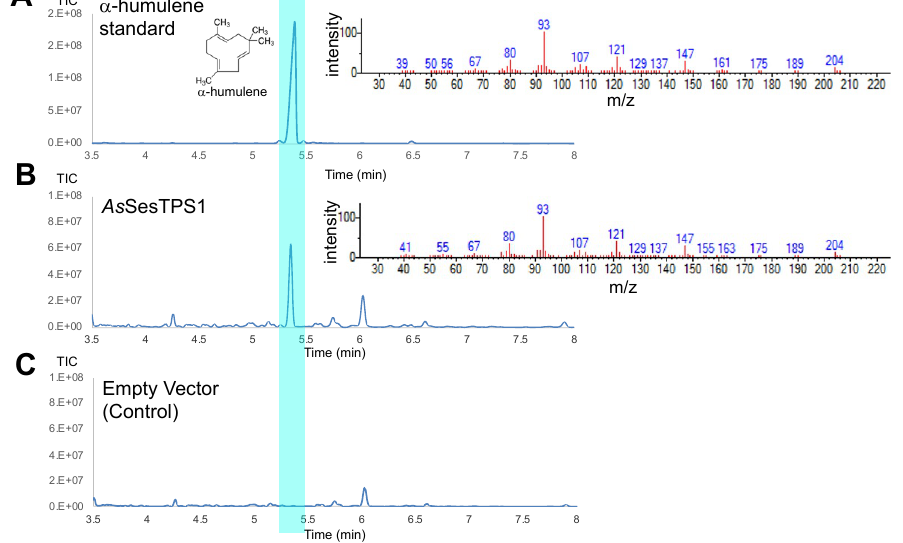
Figure 4. Total ion chromatograms (left panel) and mass spectra (right panel) obtained from GC-MS 353 analysis of an authentic standard for α -humulene ( A ) and dodecane samples from the cultivation of 354 strains FPPY005_39850 harboring pRSII426-Gal1/10-AsSesTPS1 ( B ) and FPPY005_39850 harboring 355 the empty vector pRSII426-Gal1/10 ( C ). 356